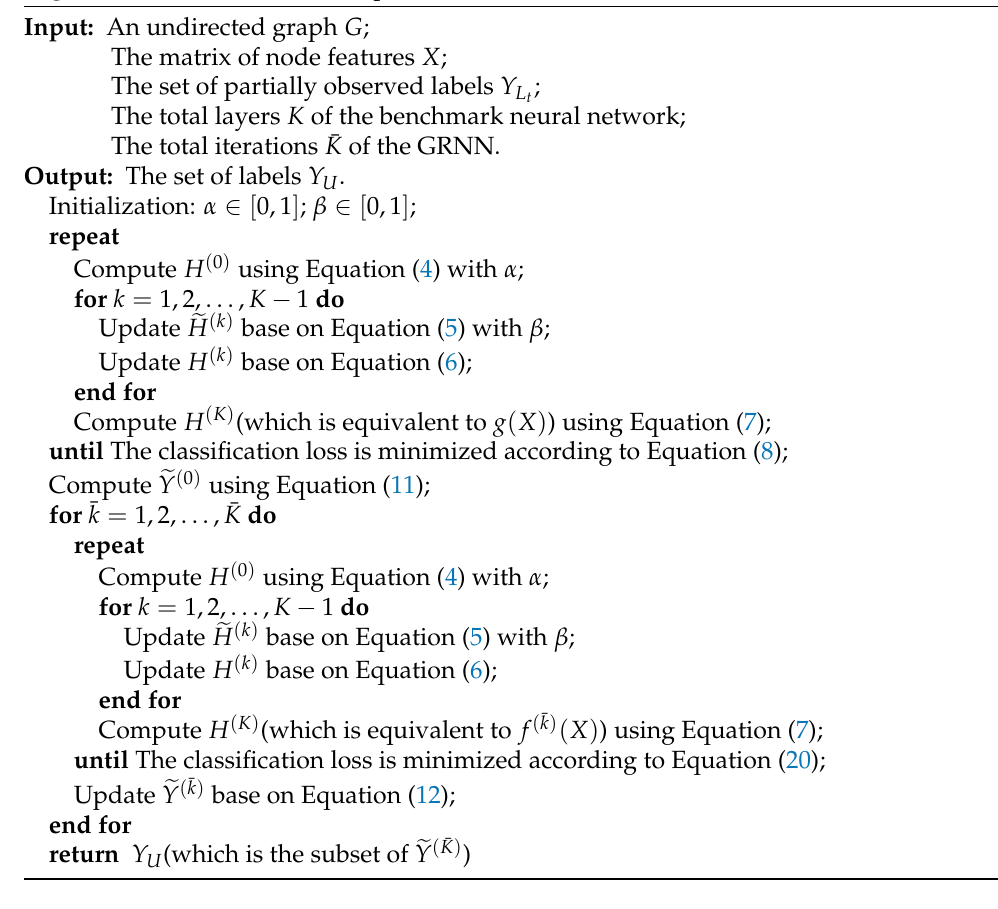
Algorithm 1 GRNN for semi-supervised node